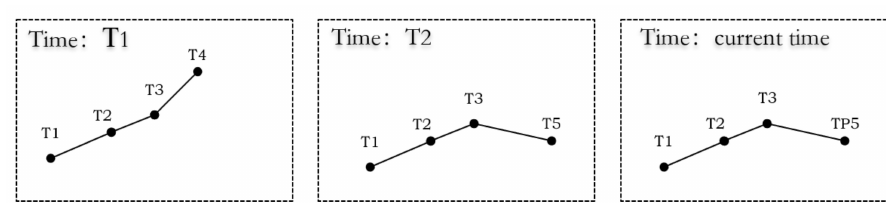
Figure 5. Geological structure spatial-temporal evolution